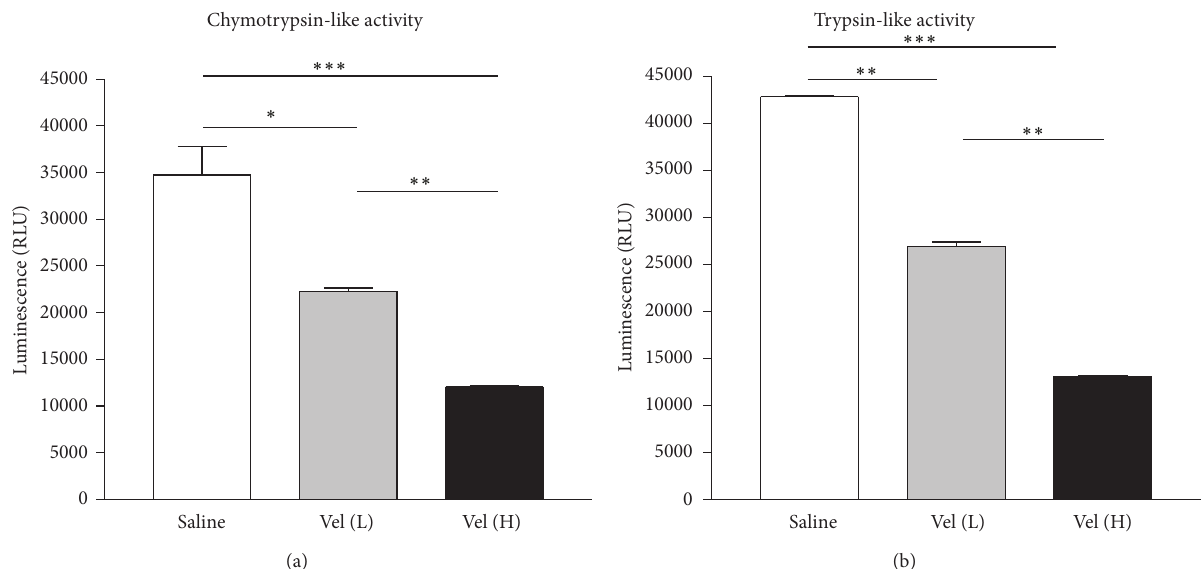
Figure 3: Evaluation of chymotrypsin-like and trypsin-like activity of the proteasome. Compared to the saline-treated EAU group, there was significantly decreased activity of chymotrypsin-like (a) and trypsin-like activity (b) in the low-dose [Vel (L)] and high-dose bortezomib [Vel (H)] groups. The activity was also markedly lowered in the high-dose bortezomib-treated group compared with the low-dose bortezomib- treated group. The data are expressed as the mean ± SD of the mean in 5 mice for each group (bar graph). ∗ 𝑃 < 0.05 , ∗∗ 𝑃 < 0.01 , and ∗∗∗ 𝑃 < 0.001 , via Student’s 𝑡 -test. The experiment was repeated three times with similar results.